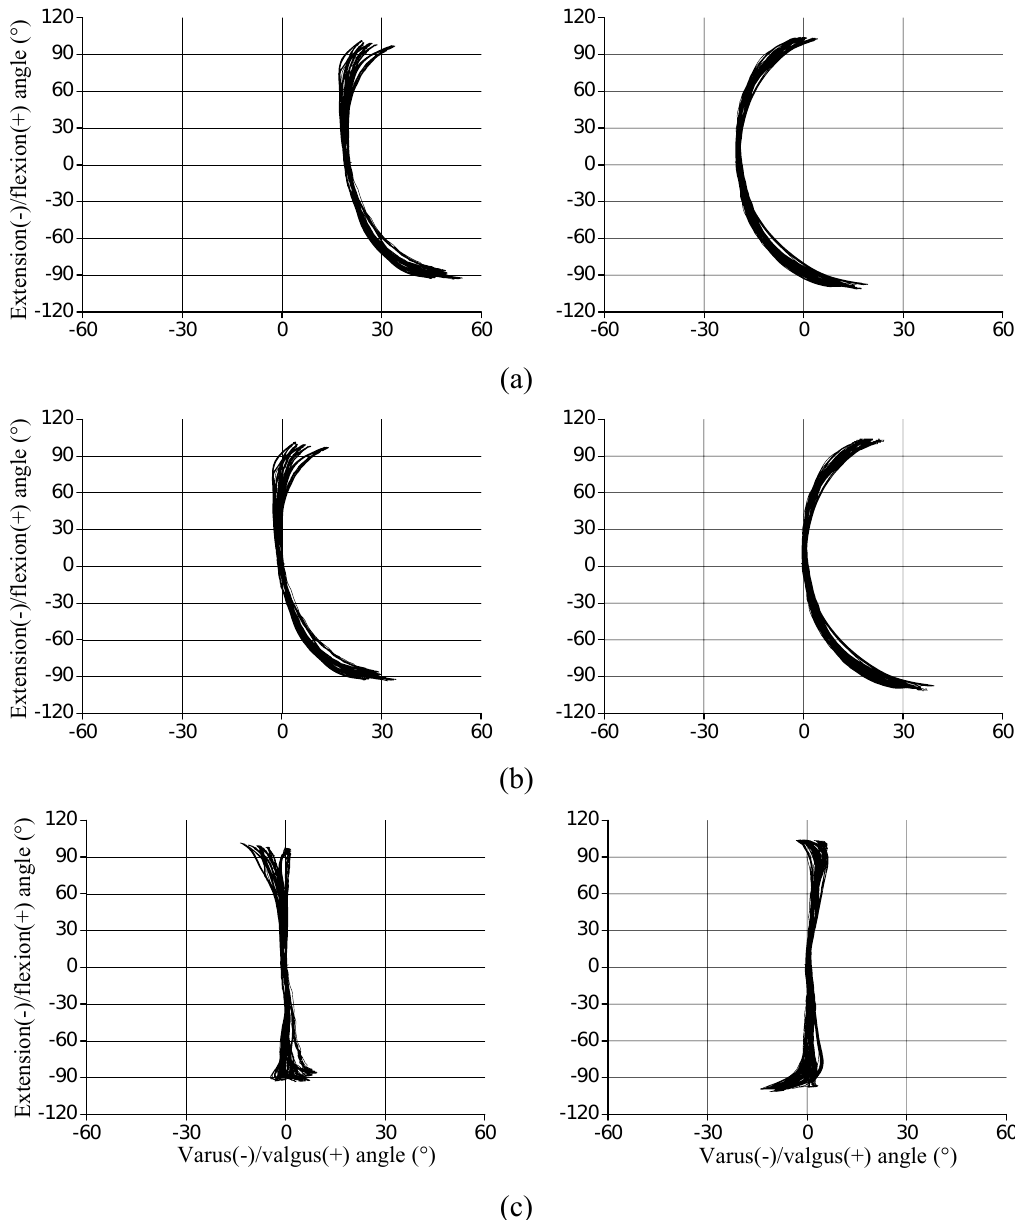
Figure 5. X-Y plots of valgus/varus and flexion/extension angles for valgus (left graphs) and varus (right graphs) misalignments of 20° distributed between the thigh and shank (10 trials). For each trial, about 15 movements of ±100° pure flexion/extension were performed. (a) Raw data; (b) Offset compensated data; (c) Offset and individual crosstalk compensated